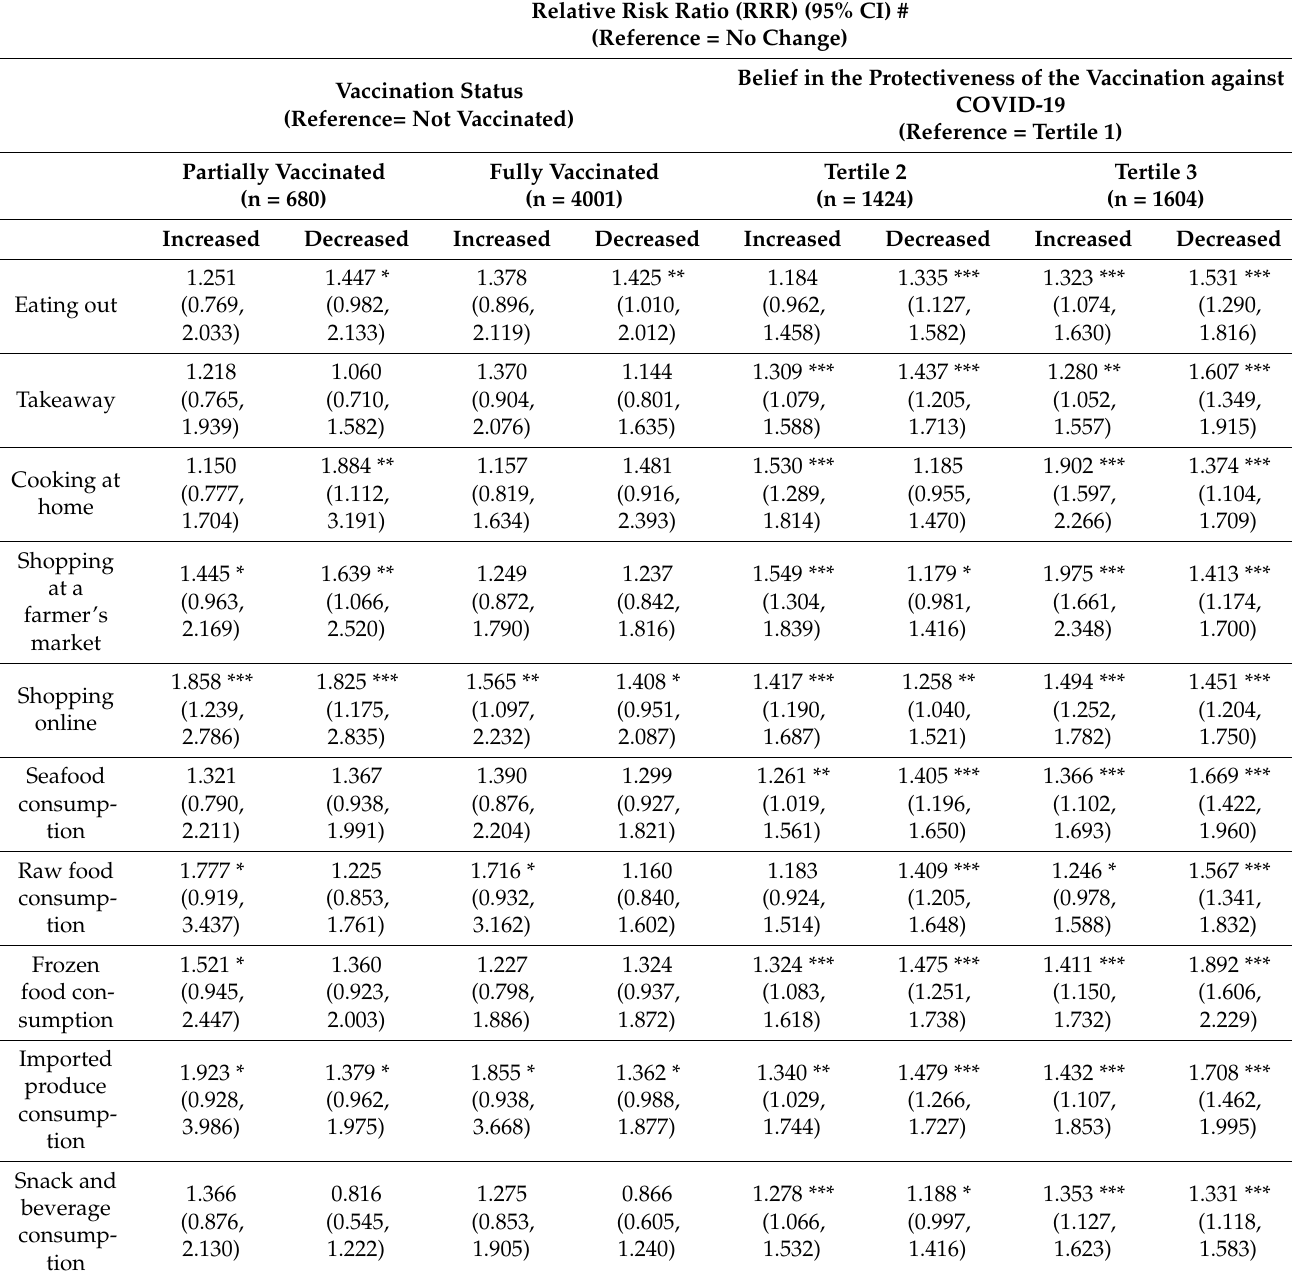
Table 4. Changes in dietary behaviors in comparison to early